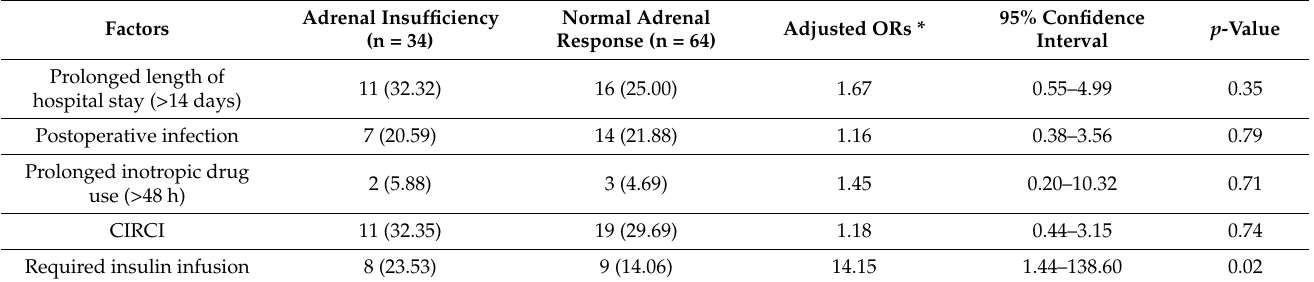
Table 2. Multivariable analysis of postoperative outcomes and screening for adrenal